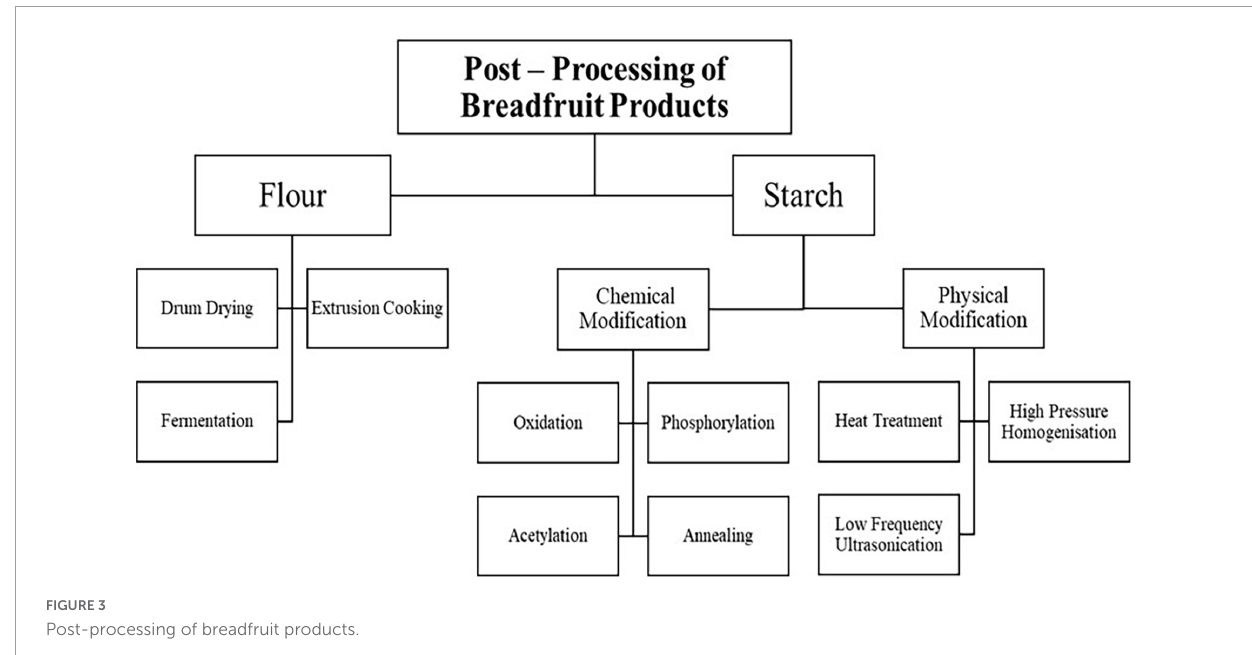
FIGURE3 Post-processing of breadfruit products.